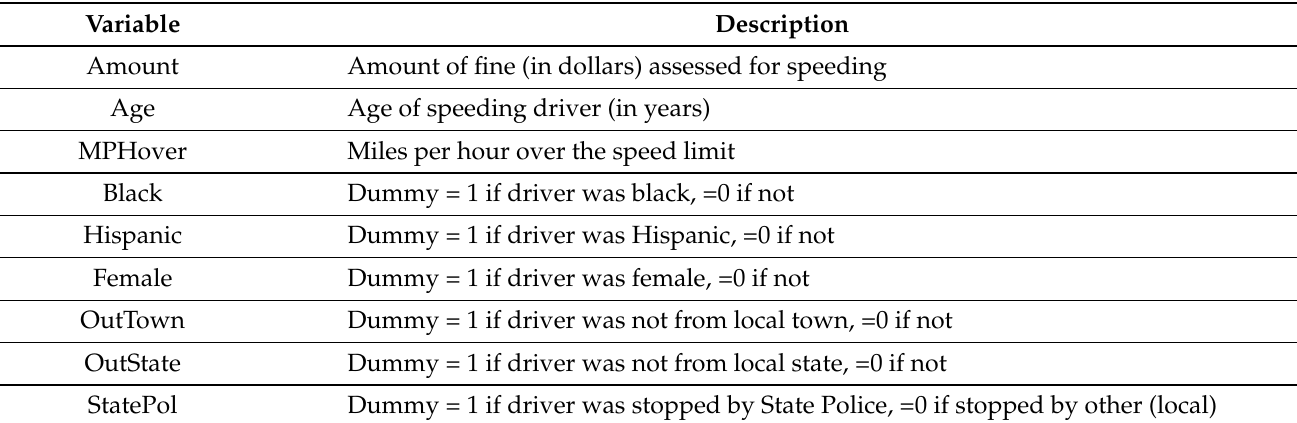
Table 2. Variables and description of speeding ticket data.